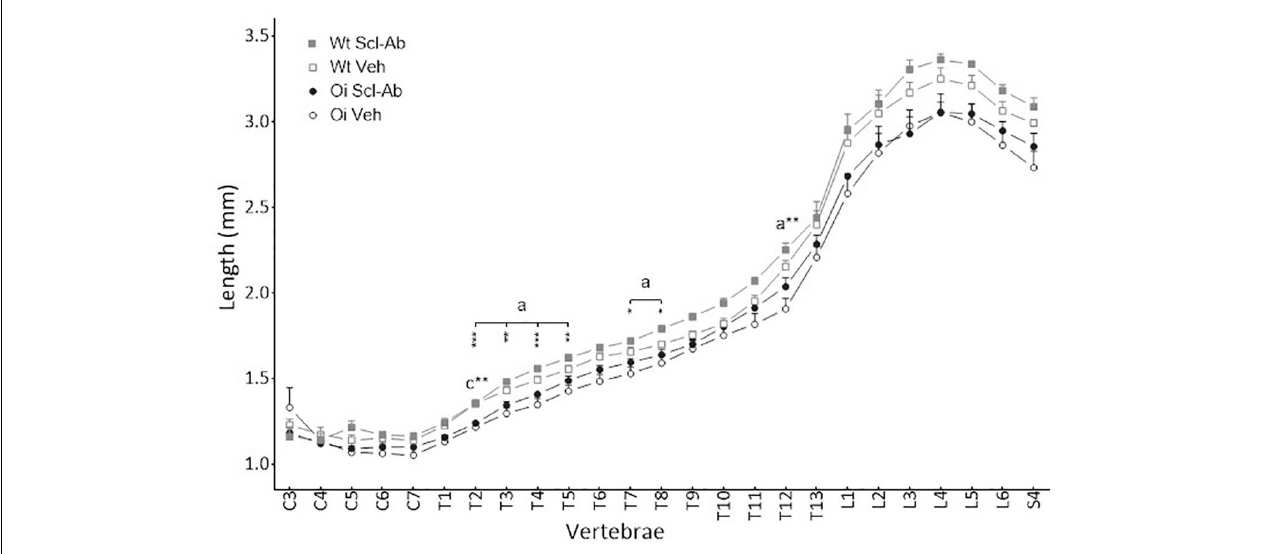
FIGURE 3 | Vertebral body length from C3 to S4 assessed by sagittal pQCT in male wild-type (Wt) and oim/oim (OI) mice after 9-week treatment with either Scl-Ab or vehicle (Veh.). Results are expressed as mean + SEM; a = OI Veh. versus Wt Veh.; c = OI Scl-Ab versus Wt Veh.; * p < 0.05, ** p < 0.01, *** p < 0.001.